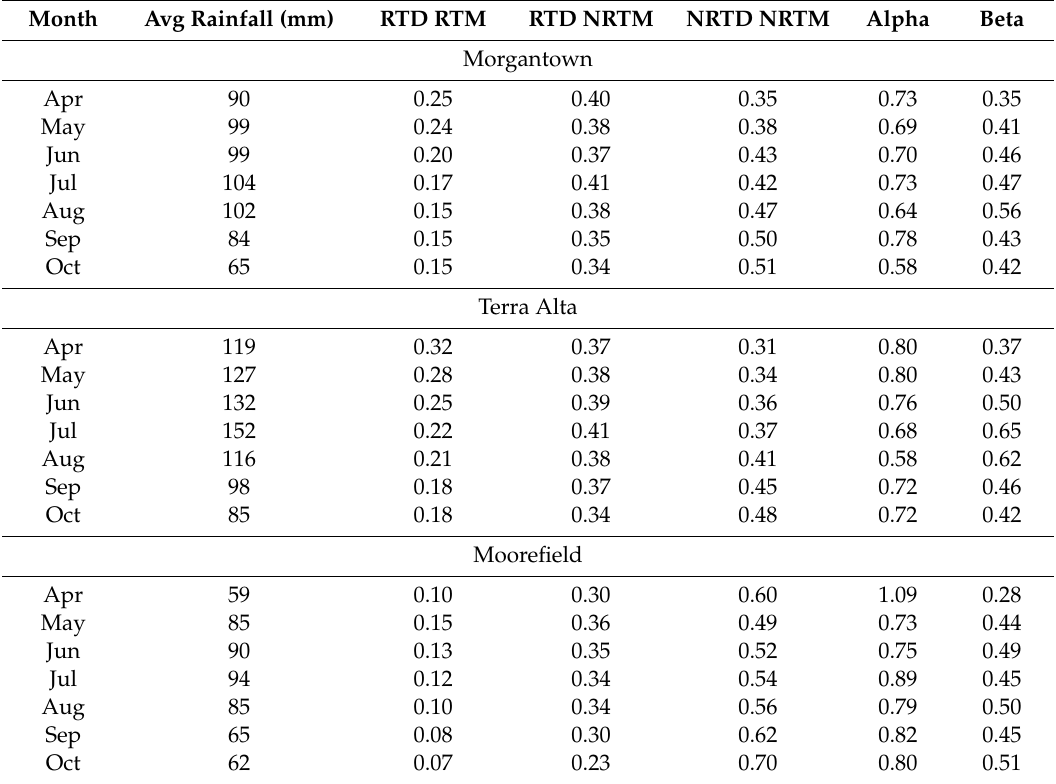
Table 6. Growing season rainfall and rainfall probabilities used in the stochastic pasture growth model: probability that there will be two days in a row with rain (rain today it will rain tomorrow, RTD RTM), probability that there will be a day with rain and a day without rain in a row (rain today it will not rain tomorrow or visa versa, RTD NRTM), probability that there will be two dry days in a row (no rain today it will not rain tomorrow, NRTD NRTM); and gamma probability distribution alpha and beta coe ffi cients for the amount of rain occurring on days when it does rain.